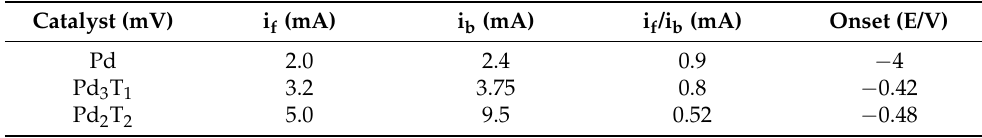
Table 1. Performance parameters of Pd-based electrode